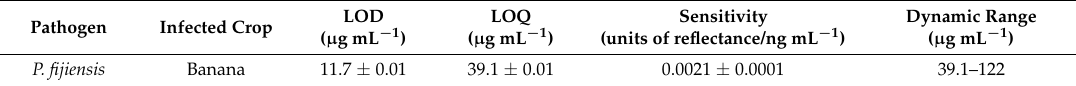
Table 1. Analytical parameters of SPR based biosensors for black Sigatoka pathogen detection.